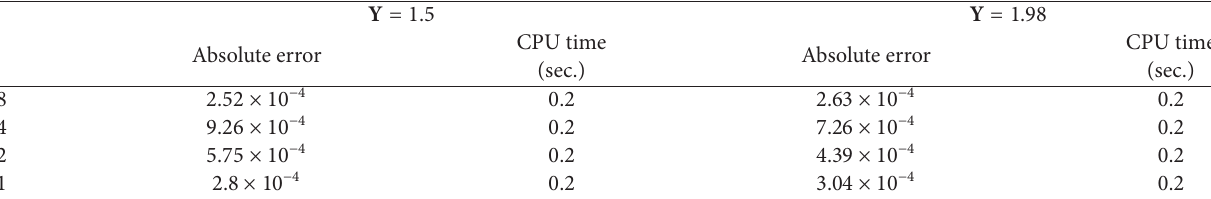
Table 5: Comparison of errors due to the variation of 𝜀 for CGMY